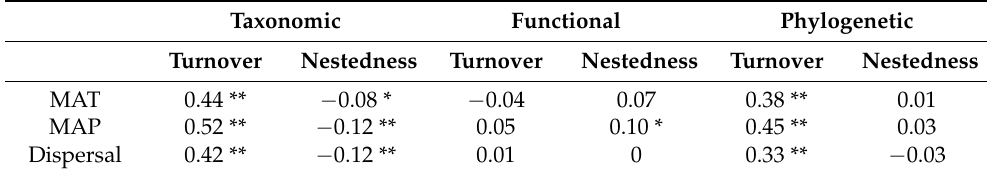
Table 1. Spearman correlations between explanatory variables and taxonomic, functional, phyloge- netic turnover and nestedness. MAT is differences in mean annual temperature; MAP is differences in mean annual precipitation; and dispersal is spatial distance. * p < 0.05; ** p < 0.01. Taxonomic Functional Phylogenetic Turnover Nestedness Turnover Nestedness Turnover Nestedness MAT 0.44 ** − 0.08 * − 0.04 0.07 0.38 ** 0.01 MAP 0.52 ** − 0.12 ** 0.05 0.10 * 0.45 ** 0.03 Dispersal 0.42 ** − 0.12 ** 0.01 0 0.33 ** −